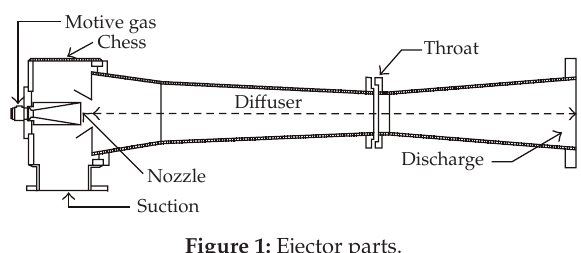
Figure 1: Ejector